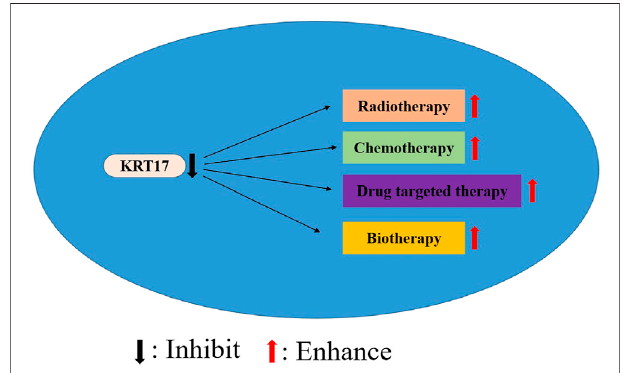
FIGURE 4 | Inhibition of KRT17 expression may improve the ef fi cacy of radiotherapy, chemotherapy, drug targeted therapy and biotherapy.